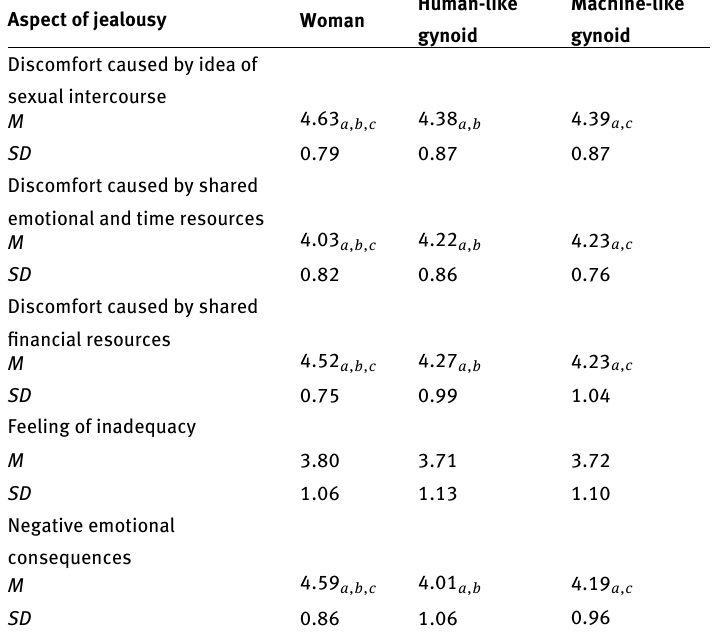
Table 1: Means and significant differences of the jealousy aspects. Note . Means in column-sharing subscripts are significantly different from each